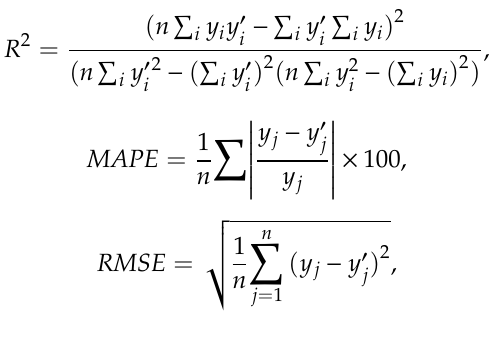
Table 3. Details of the setting of six investigated architectures from artificial neural network (ANN), deep neural network (DNN) and deep residual network (ResNet).